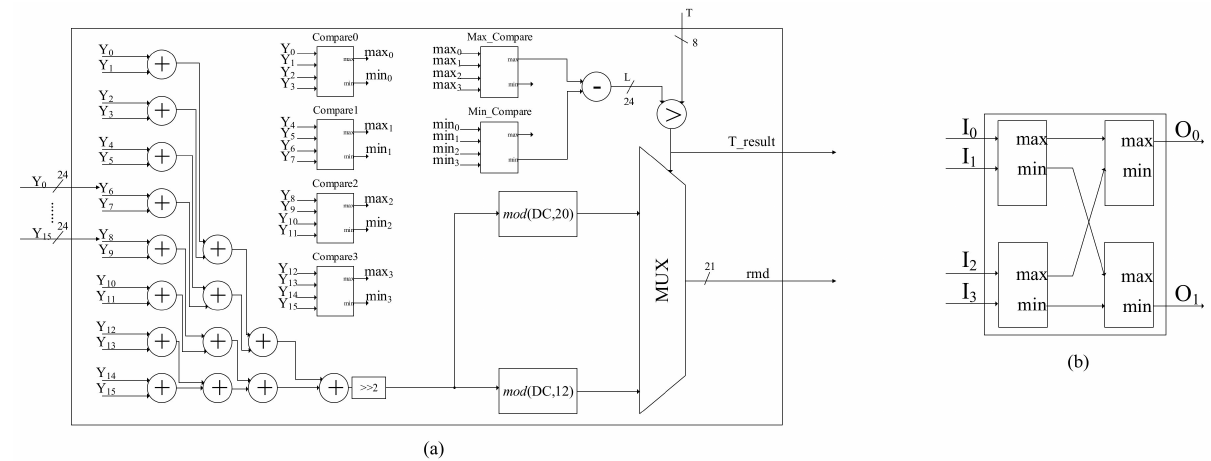
Figure 8. ( a ) Detailed diagram of watermark_prepare module. ( b ) Detailed diagram of compare module in ( a ).